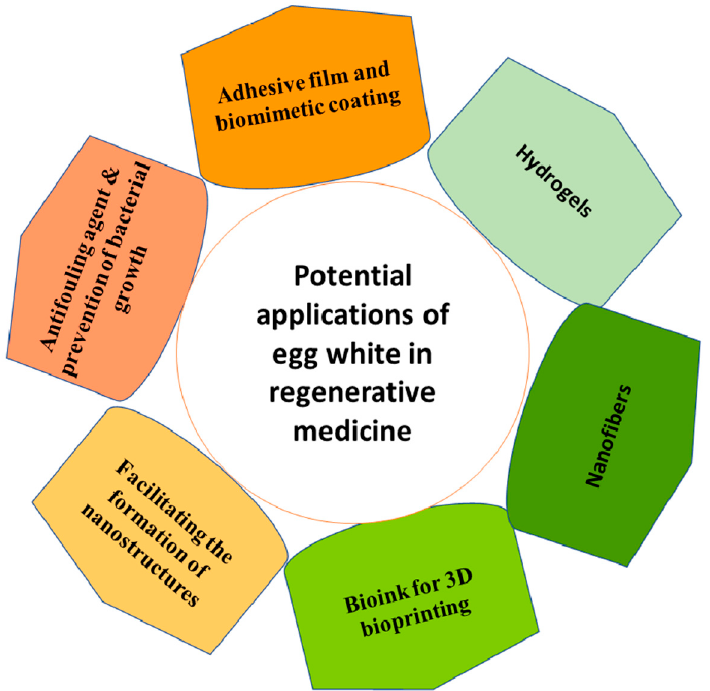
Figure 7. Different applications of egg white in regenerative medicine. As a rich source of albumin, egg white can be used to fabricate scaffolds such as hydrogels and nanofibers. It can be used as a bioink and coating agent with antibacterial properties. Moreover, egg white has antifouling properties similar to albumin.